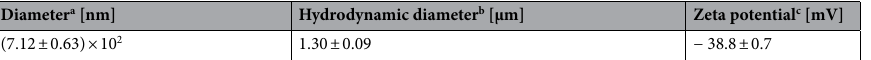
Ratio of the molar concentrations of (6,6) CNBs and C